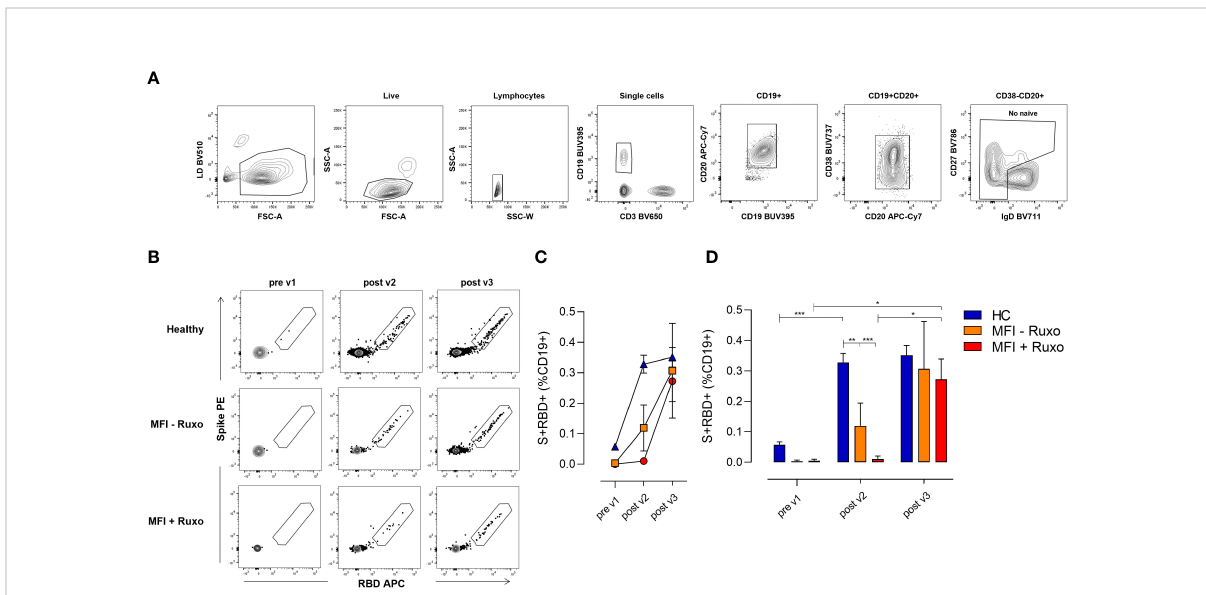
FIGURE 3 Spike-speci fi c B cell response following mRNA SARS-CoV-2 vaccination in patients with myelo fi brosis (MF), with or without ruxolitinib (Ruxo) treatment, after second and third vaccine dose. Identi fi cation of spike (S) and RBD-speci fi c B cells by fl ow cytometry within PBMCs collected at the baseline (pre v1), after two (post v2) and three (post v3) doses of mRNA SARS-CoV-2 vaccine. (A) Gating strategy for identifying CD19+ spike/RBD-speci fi c B cells (named S+RBD+ B cells) by multiparametric fl ow cytometry. (B) Representative dot plot analysis of spike PE versus RBD APC within CD19+ cells, for identifying S+RBD+ B cells in MF subjects with and without therapy, and in healthy controls (HC). (C) Mean value (±SEM) of S+RBD+ B cells percentages at different time points evaluated in MF subjects with and without therapy, and in HC. (D) Frequencies of S +RBD+ B cells on CD19+ cells at different time points evaluated in MF subjects with and without therapy, and in HC. Kruskal-Wallis test, followed by Dunn ’ s post test for multiple comparisons, was used for assessing statistical differences between different groups each time point. Unpaired Mann- Whitney test was used to assess statistical difference at each group at different time points. *P ≤ 0.05; **P ≤ 0.01; ***P ≤